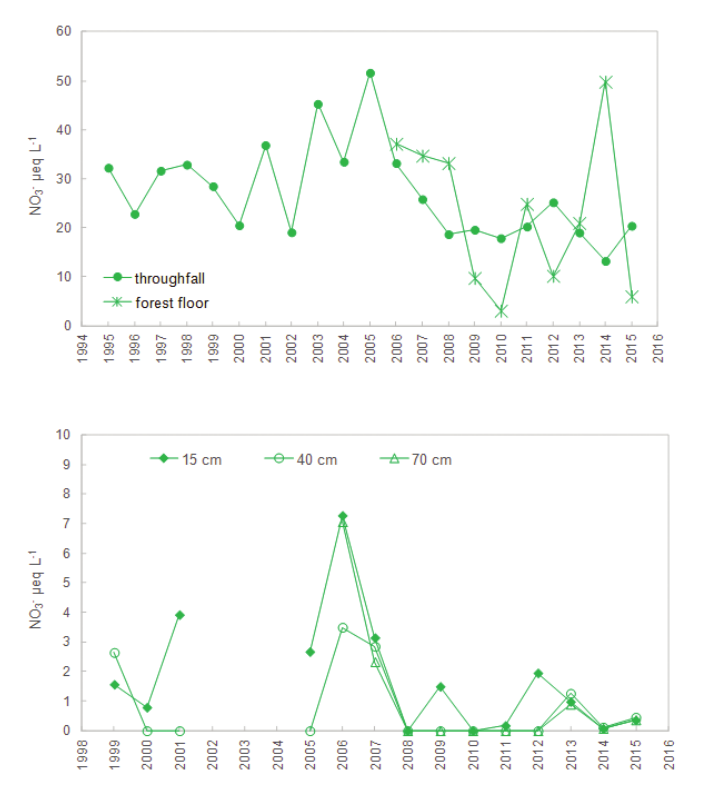
Figure 6. Annual NO concentrations measured in throughfall and forest floor leachates (a) and in the 3 topsoil solution (TS), subsoil solution (SS) and in deep soil solution (DS) (b) during the study